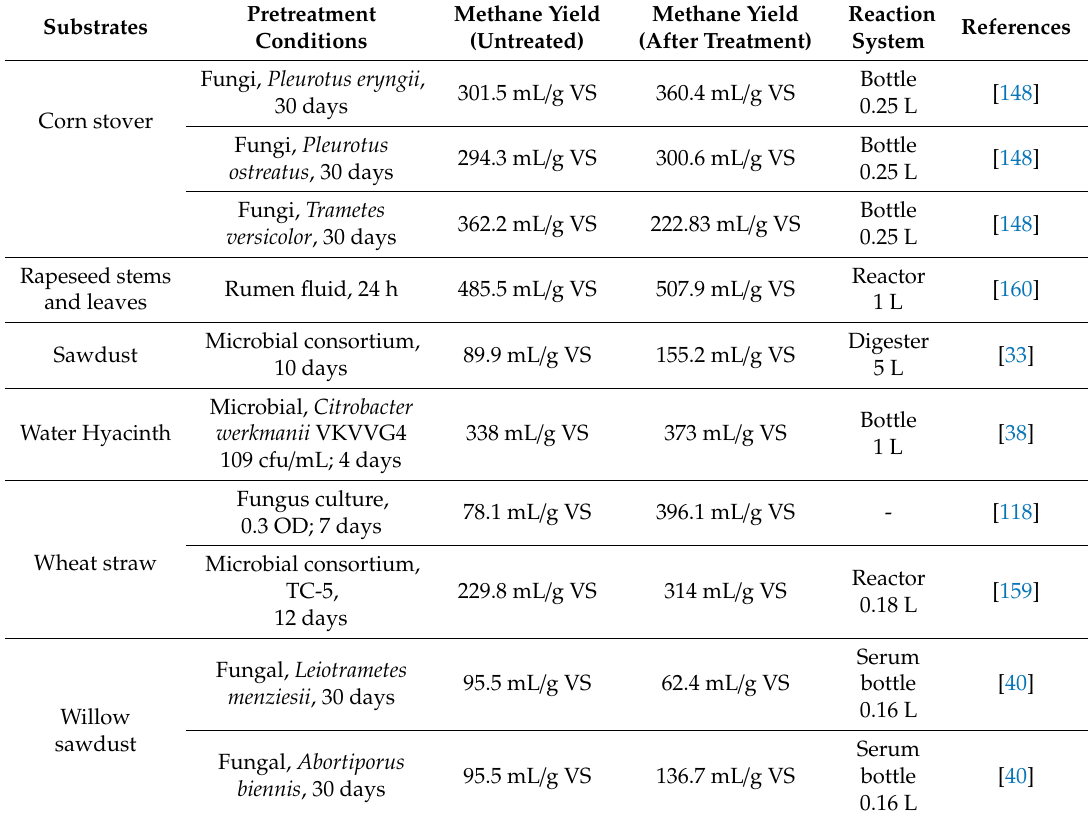
E ff ect of di ff erent biological pretreatments on methane yield from di ff erent lignocellulosic